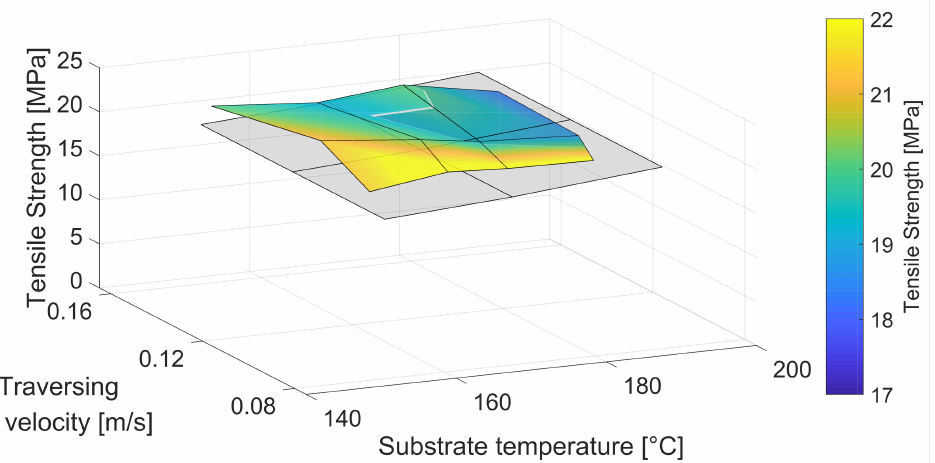
Figure 10. Tensile strength of cooled specimens at 50 mm cooling distance in the transverse direction with the reference tensile strength for uncooled specimens at the final substrate temperature